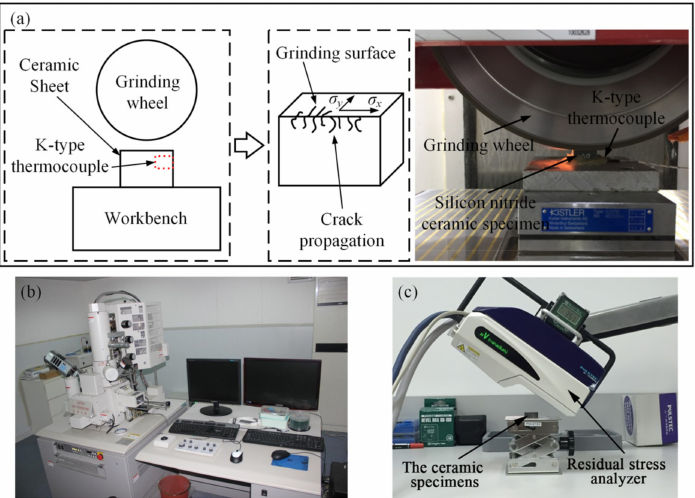
Figure 1. Grinding experiment and measuring equipment: ( a ) Experimental principle and processing; ( b ) SEM; ( c ) Residual stress